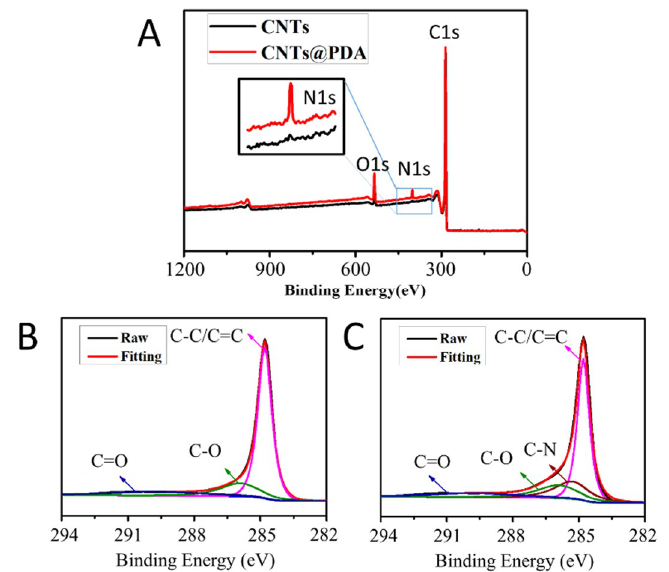
Figure 3. The x-ray photoelectron spectroscopy of pure CNTs and CNTs@pDA. ( A ) The elemental analysis of pure CNTs and CNTs@pDA. Compared with the spectra of pure CNTs, the spectra of CNTs@pDA had a significant N-element absorption peak appeared at about 400 eV and a higher O-element absorption peak. ( B ) The XPS spectroscopy of the bond between the elements of pure CNTs. ( C ) The XPS spectroscopy of the bond between the elements of CNTs@pDA. Compared with the results of pure CNTs, there was a C–N bond in CNTs@pDA.